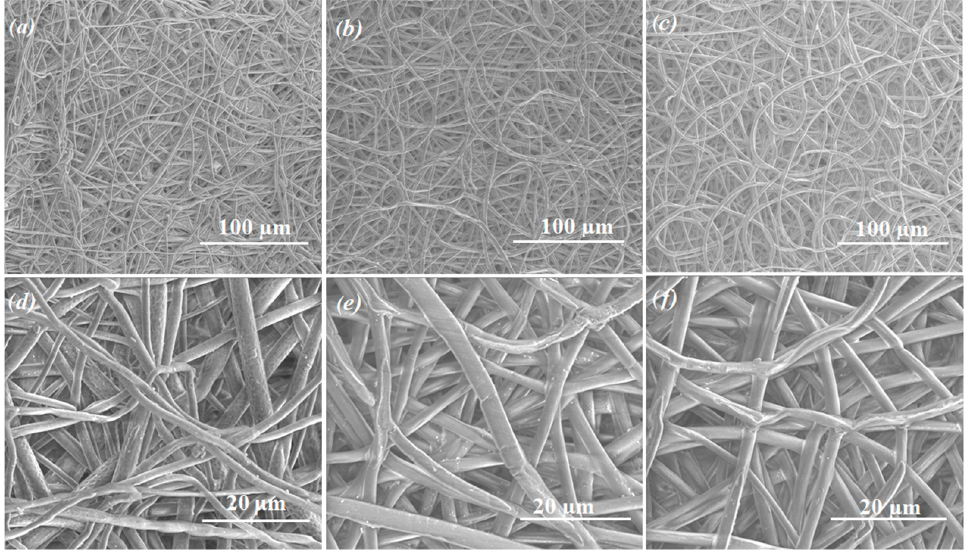
Figure 6. SEM micrographs of PGCL/PLGA + CTX patches during incubation in PBS pH = 7.4 and 37 °C. ( a , d ) 4 weeks; ( b , e ) 8 weeks; ( c , f ) 12 weeks of incubation. (PGCL/PLGA) + CTX patches were found to be more suitable for prostate cancer therapy and were selected for final, anticancer activity analysis.